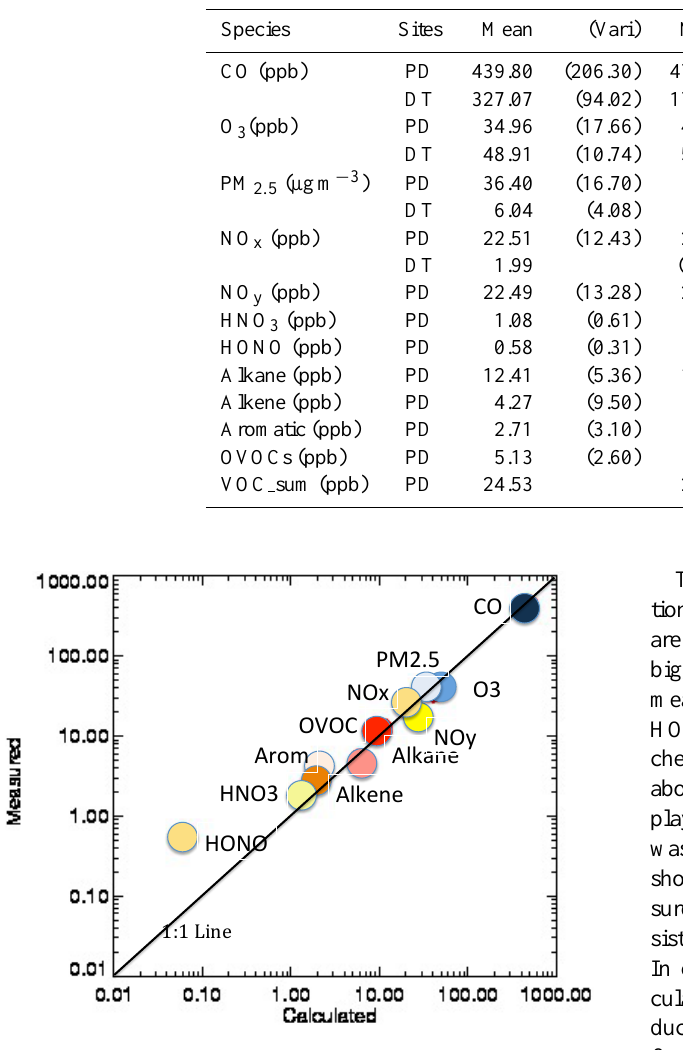
Fig. 6. Comparisons of the mean values of measured (y-coordinate) and calculated (y-coordinate) air pollutants (CO, O 3 , PM 2 . 5 , etc) at the PD